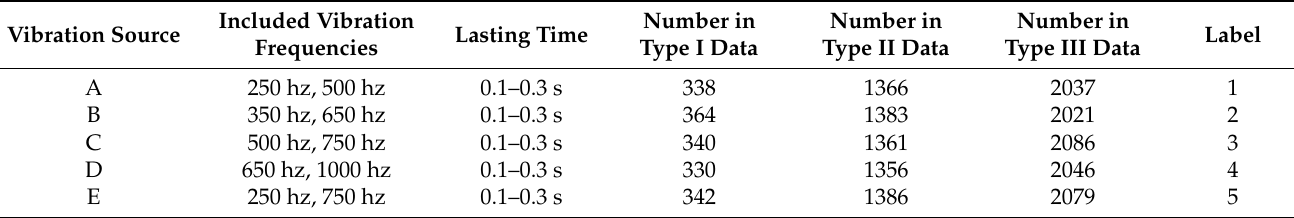
Table 1. Description of the distribution of different vibration